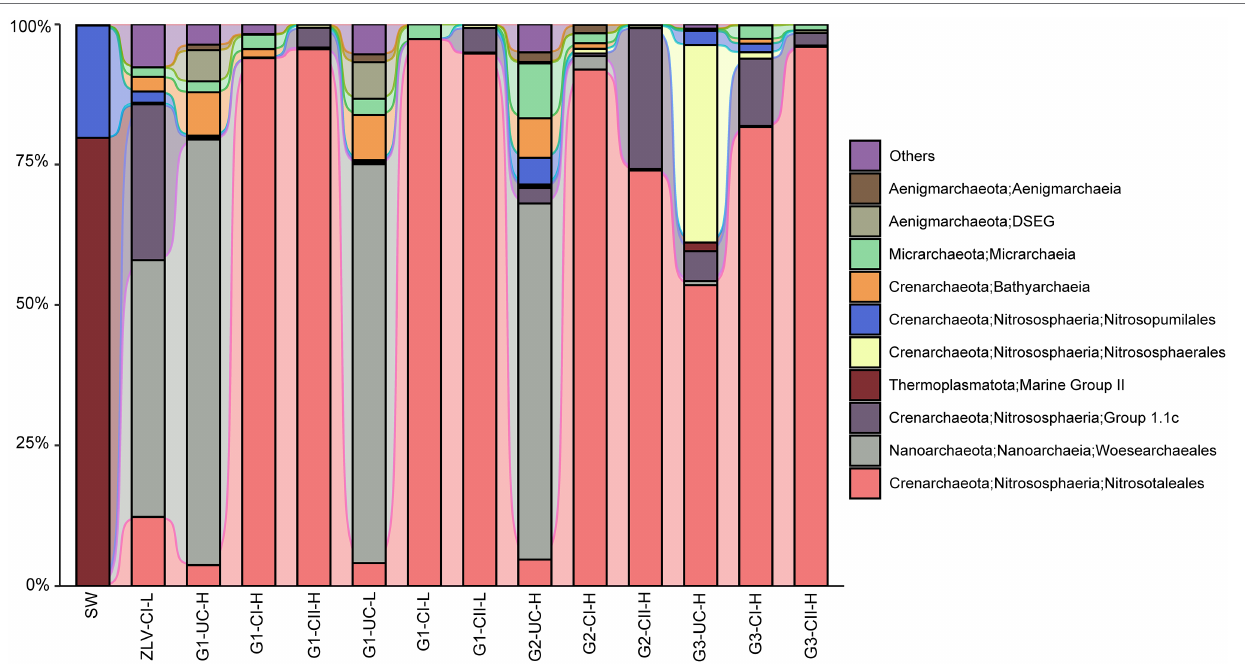
FIGURE 7 | Alluvial bar plot of archaeal community composition and their relative abundance. Only the top 10 groups with a relative abundance greater than 0.1% in all the samples are shown in the figure, and the remaining taxa were grouped together as “others” ( Supplementary Figure 3B ). DSEG: Deep Sea Euryarchaeotic Group. G1, G2 and G3 indicate monitoring site. ZLV, groundwater outlet at Zhuoluo; SW, seawater; UC, unconfined aquifer; CI, confined aquifer I; CII, confined aquifer II; H, high tide; L, low